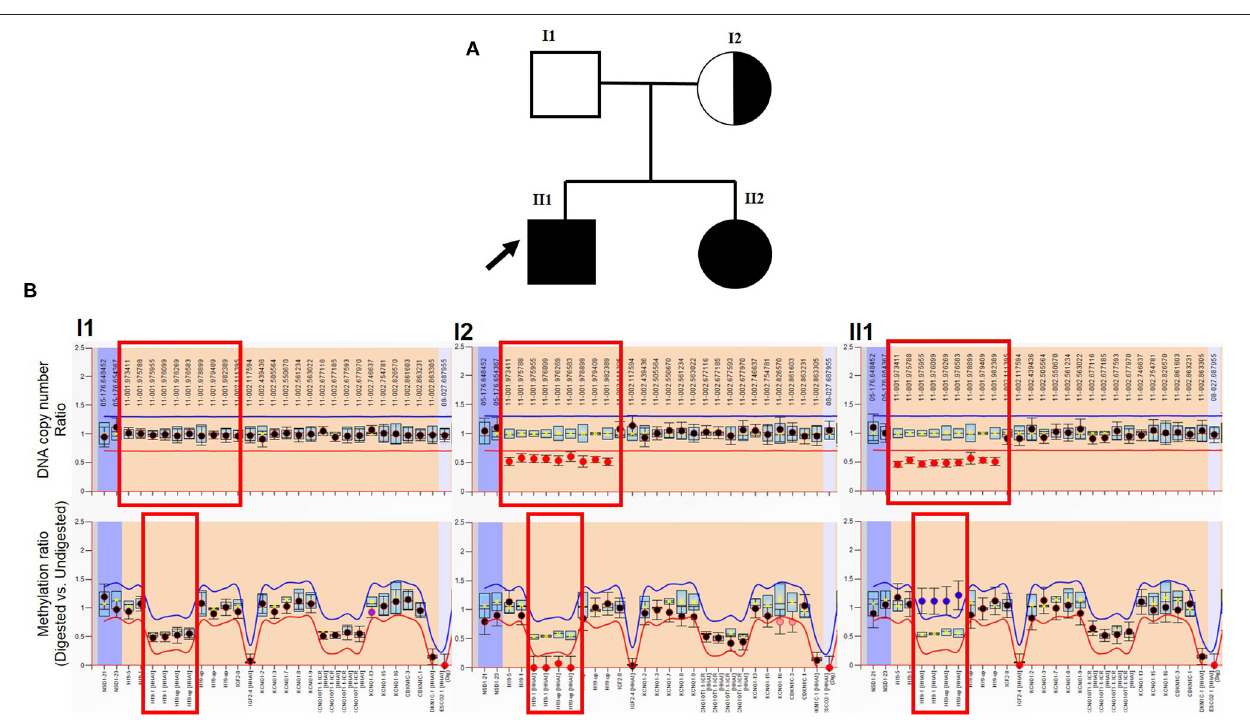
FIGURE 2 | MLPA result of patient. (A) Genogram of the BWS family. The arrow points out the male patient (proband) in our study. (B) Top row: DNA copy number ratio of patient vs. normal reference. The X -axis shows hg18 locations. The red box points out H19 and its upstream location. It shows normal ratio ( ∼ 1) in the patient’s father, and about half ( ∼ 0.5) in the male patient, and his mother (also in his sister, which is not presented here). Bottom row: methylation ratio of H19. The X -axis shows gene exons. The red box points out H19 and the upstream region. It shows normal ratio ( ∼ 0.5) in the patient’s father. Because his mother lost the methylation copy of H19 , the methylation level is about 0. The male patient lost the maternal copy of H19 (also in his sister, which is not presented here), which should not be methylated, which leads to the methylation level increase ( ∼ 1).